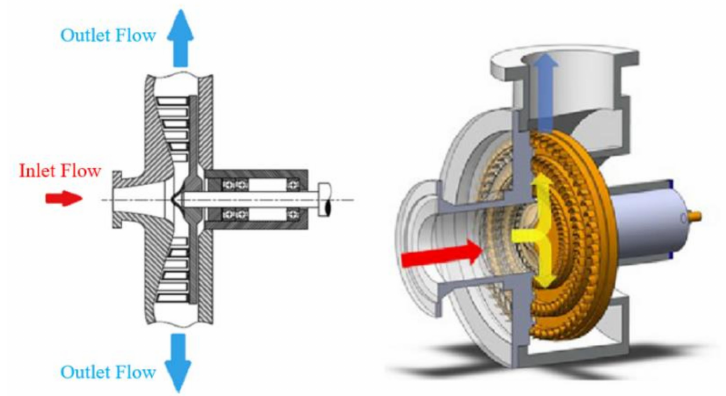
Figure 1. Typical structure of a radial outflow turbine (Adapted from